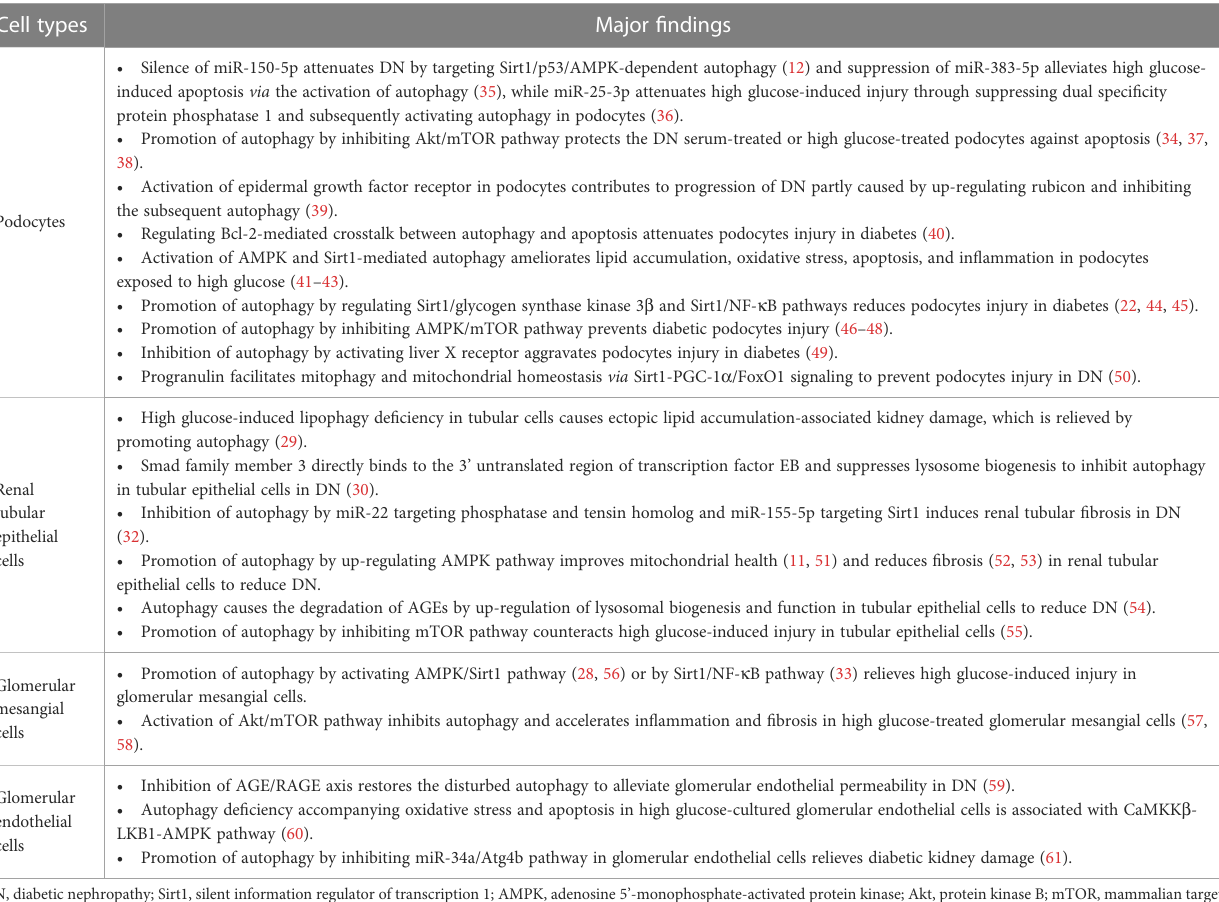
TABLE 1 Autophagy in four types of renal cells during